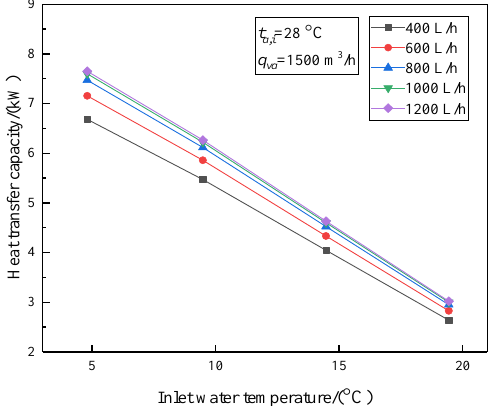
Figure 11. Variation of heat transfer rate under different water flow rates.